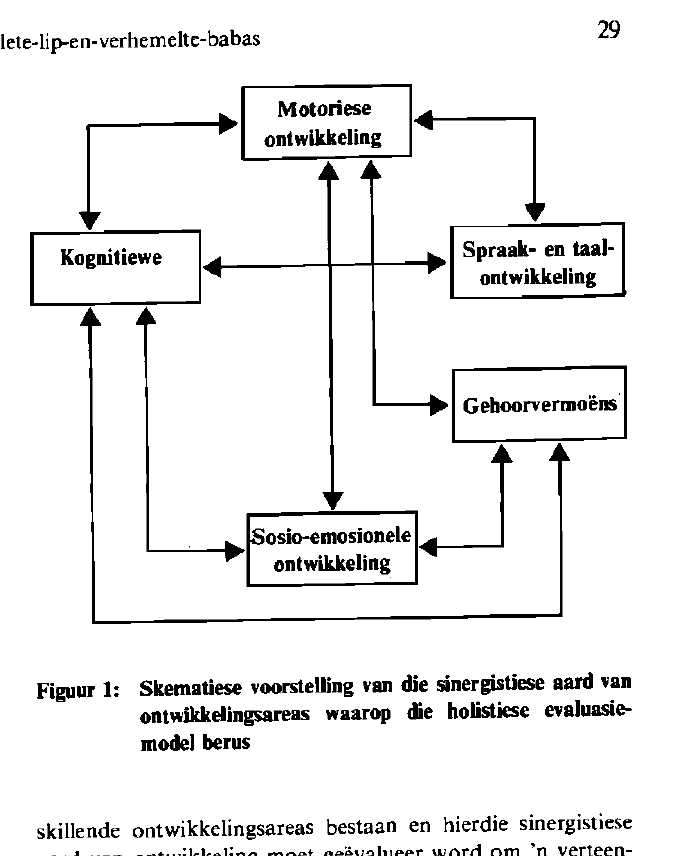
Figuur 1: Skematiese voorstelling van die sinergistiese aard van ontwikkelingsareas waarop die holistiese evaluasie- model